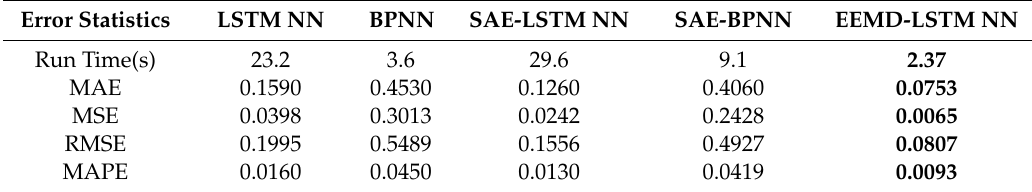
Table 2. Performance Comparison with Related Forecasting Models